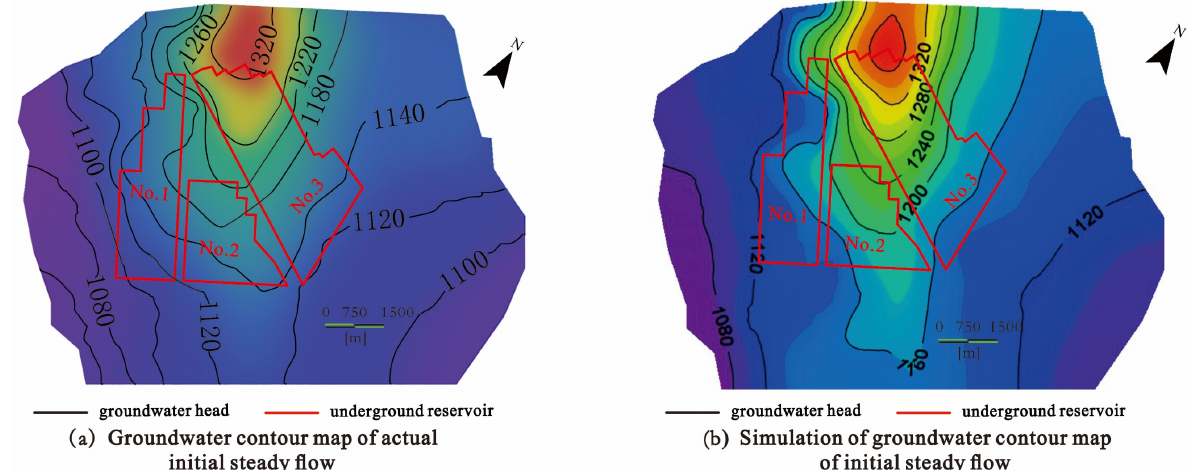
Figure 5. Comparison of actual and simulated initial steady-flow groundwater-level isolines.